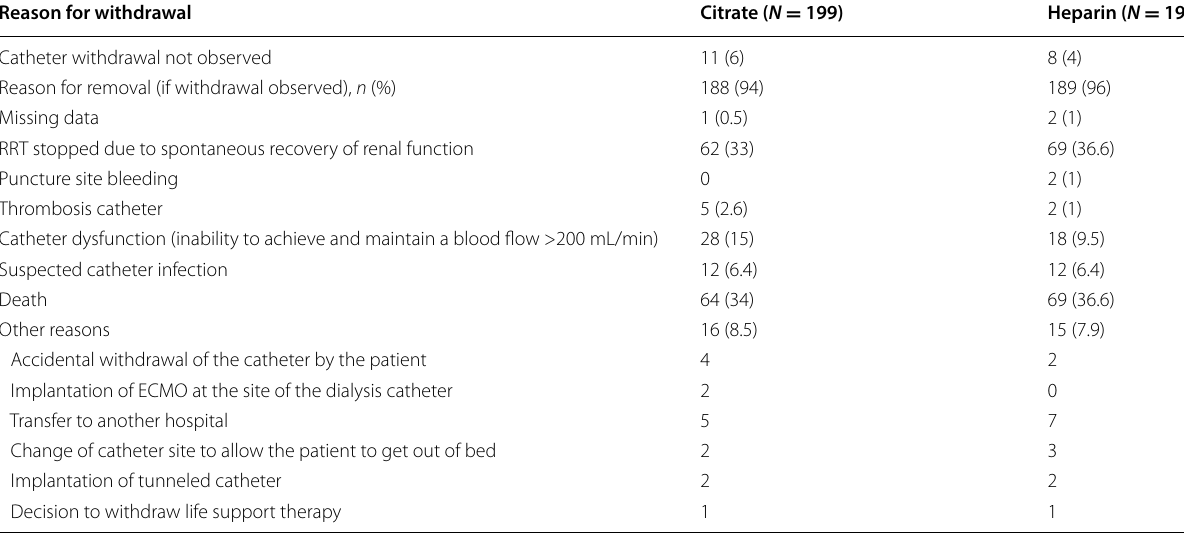
Table 3 Reason for the withdrawal of the first non-tunneled hemodialysis catheter (among patients in whom withdrawal was